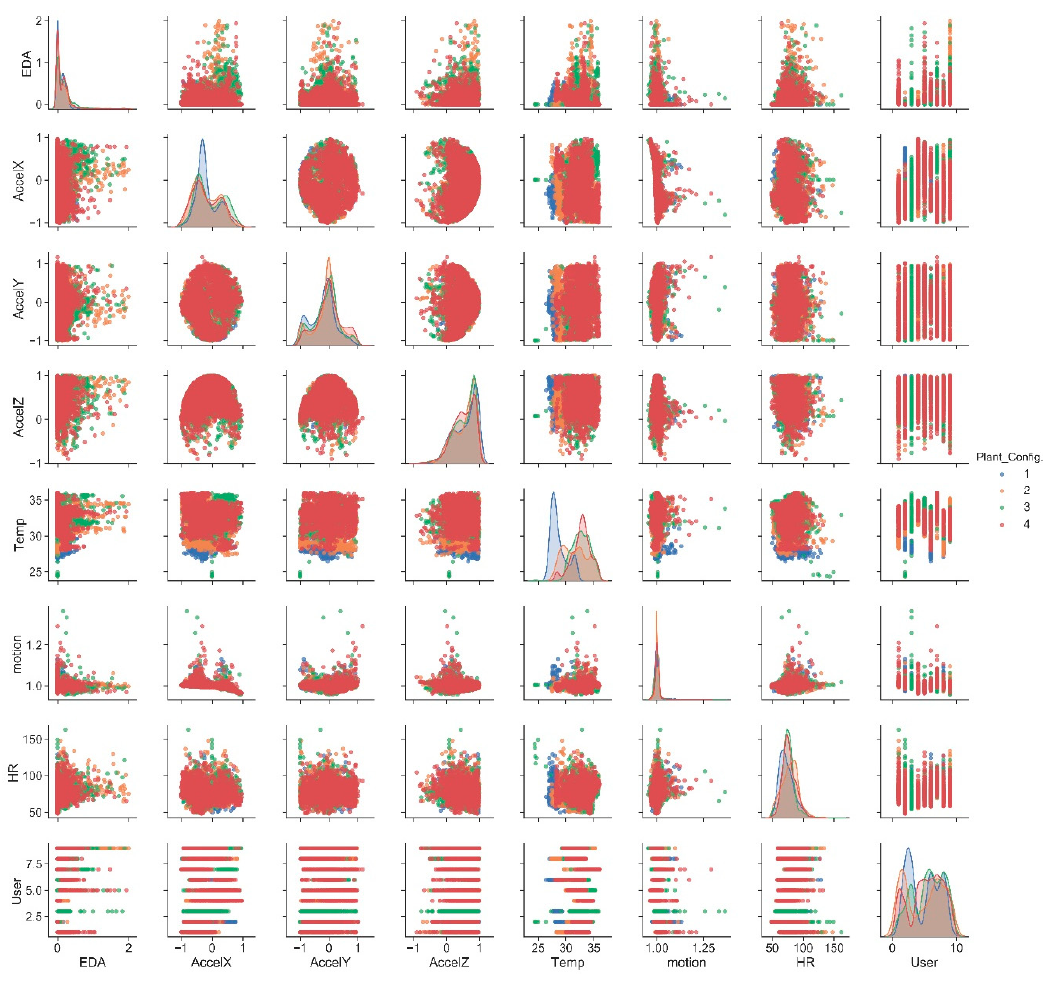
Figure 7. Correlation matrix between biometric parameters.